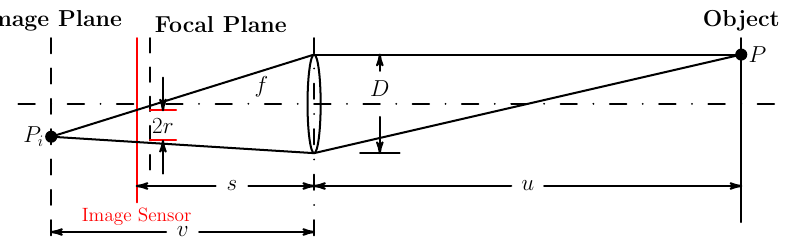
Figure 11. Principle diagram of the defocus